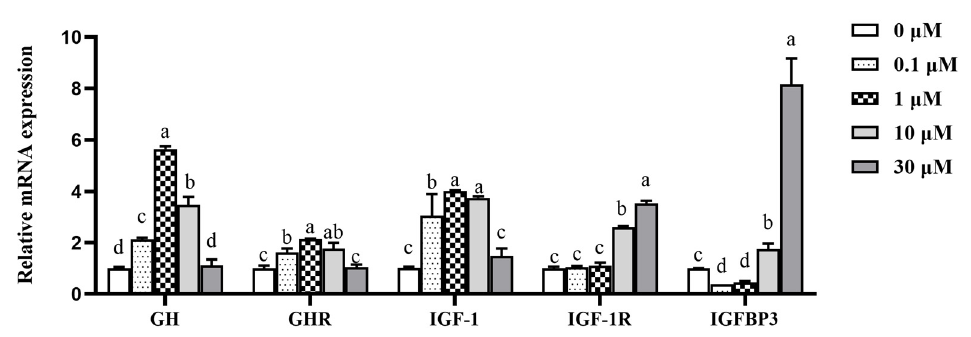
Figure 4. Effects of β -sitosterol on the expression levels of genes related to GH/IGF-1 axis in MAC-T